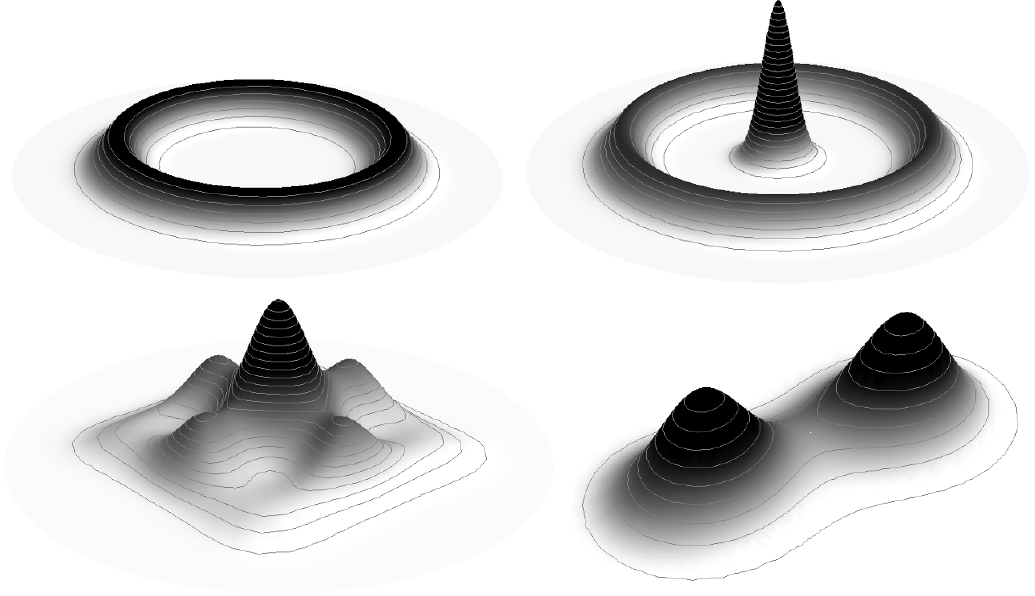
Figure 2 . Four examples of bumpy solutions: upper Left: ring-like ripple. Upper Right: Saturn- like ripple Lower Left: black (cid:13)ower with a quadrupolar deformation. Lower Right: dumbbell. Plots show the mass density m . Coloring was chosen to highlight the important details of the solution, strictly speaking all solutions share the same horizon